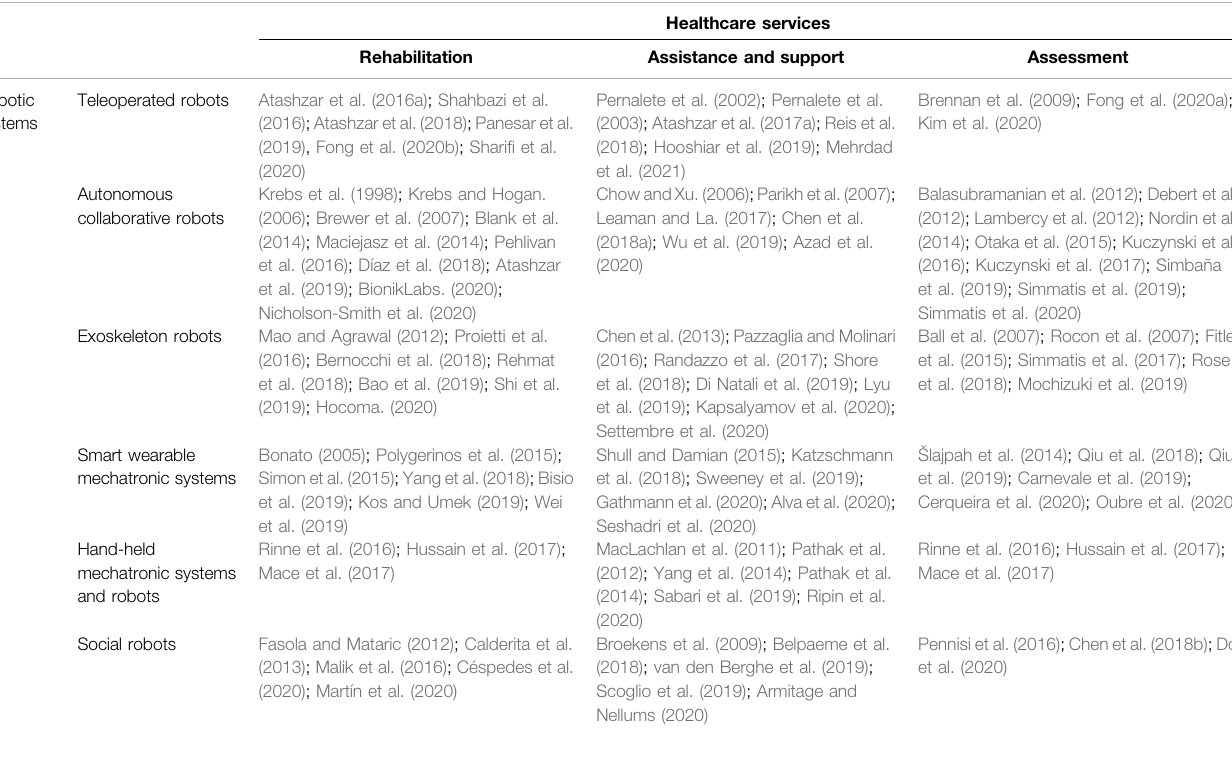
TABLE 2 | Categorization of selected articles from the